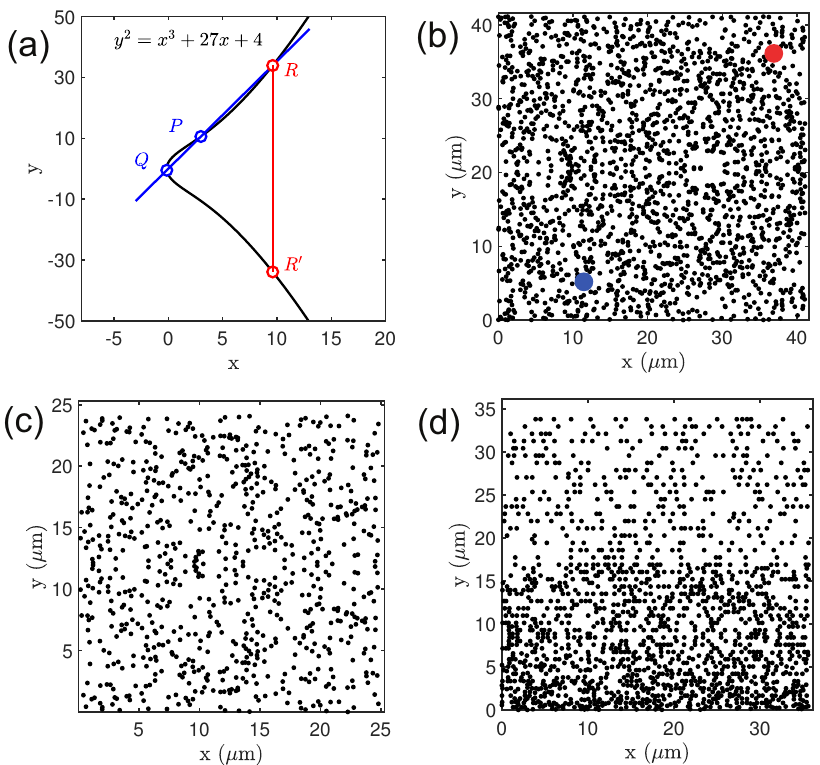
Figure 1. ( a ) Continuous elliptic curve generated by Equation (1) when the coefficients A and B are equal to 27 and 4, respectively. The sum operation on elliptic curve R (cid:48) = P ⊕ Q is also shown. ( b ) Point pattern generated from the continuous curve of panel ( a ) defined over the finite field F 2111 rescaled to have an average interparticles separation equal to 450 nm. The red and blue point marker identifies two representative points W and M , respectively. Panels ( c , d ) show the point patterns generated by solving the discrete log problem W = kM . Specifically, panels ( c , d ) are characterized by the coordinates ( M x ; k ) and ( M y ; k ) , respectively. Also for these geometries we rescaled the generated point patterns to have an average interparticles separation equal to 450